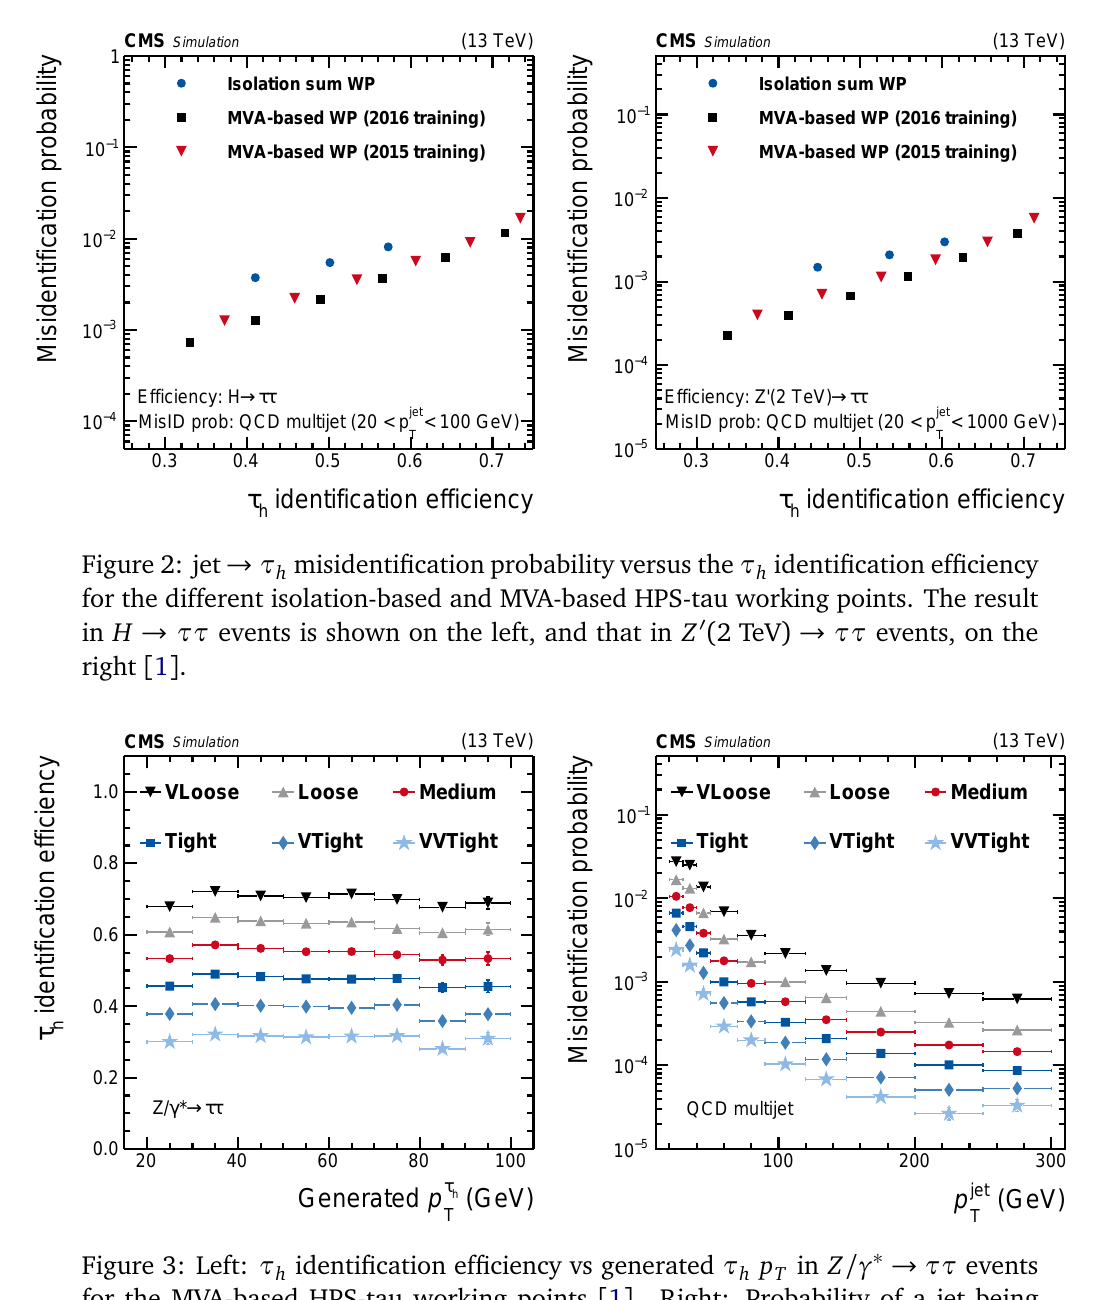
Figure 3: Left: τ identification efficiency vs generated τ h for the MVA-based HPS-tau working points [ 1 ] . Right: Probability of a jet being misidentified as a τ in QCD multijet events for the same working points [ 1 ] h